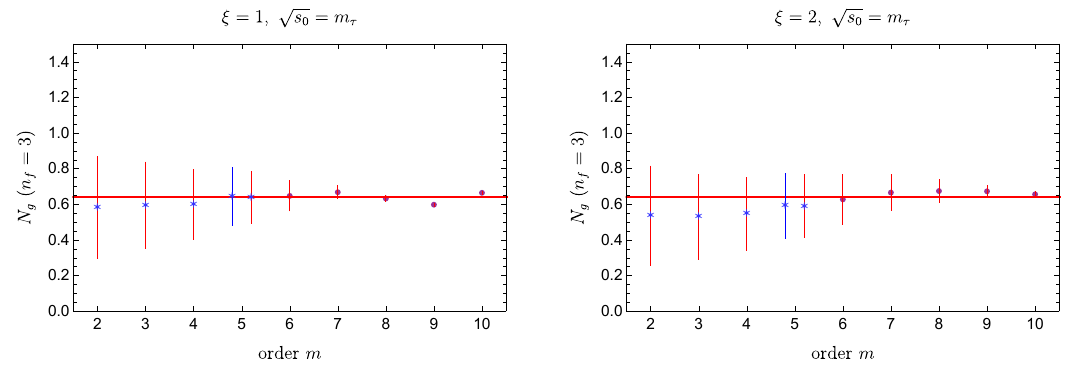
Figure 2 . Results for the n f = 3 GC renormalon norm N g up to order m = 10 obtained from the optimal subtraction approach using the Adler function obtained by the Borel model of eq. (3.1). The first five orders, up to O ( α 5 ) , (indicated by the blue starts) come from the known 5-loop s corrections quoted in eqs. (2.14) and the central estimate for the 6-loop coefficient ¯ c 5 , 1 of eq. (2.15). √ √ The red error bars arise from varying the IR factorization scale in the range 0 . 7 s 0 ≤ R ≤ s 0 and the markers represent the average of the maximal and minimal results at each order in perturbation theory. The blue error bar at order m = 5 is obtained by conservatively including, in addition to the R variations, independent variations of ¯ c 5 , 1 within the uncertainty estimate of eq. (2.15). Left panel: results for s 0 = m 2 and ξ = 1 . Right panel: results for s 0 = m 2 and ξ = 2 τ τ